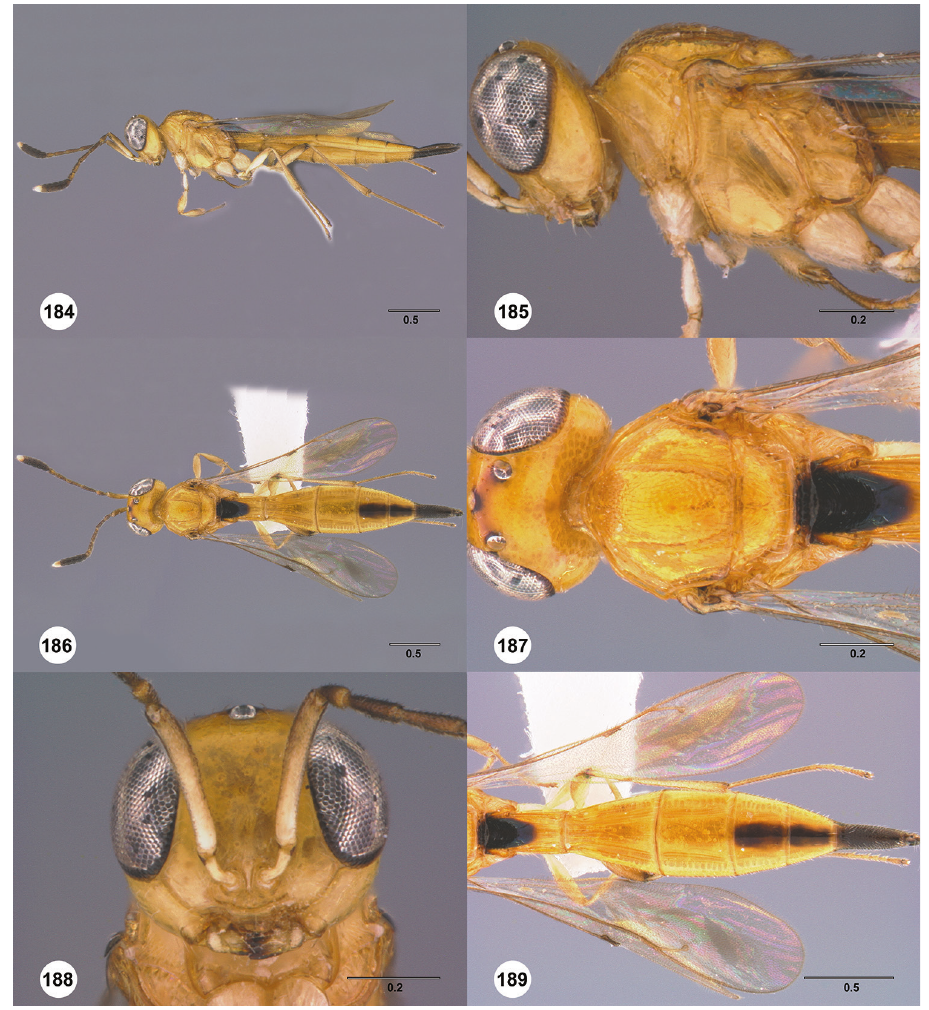
Figures 184–189. Calliscelio pararemigio sp. n., female, holotype (OSUC 458239). 184 Lateral habi- tus 185 Head and mesosoma, lateral view 186 Dorsal habitus 187 Head and mesosoma, dorsal view 188 Head, anterior view 189 Metasoma, dorsal view. Scale bars in